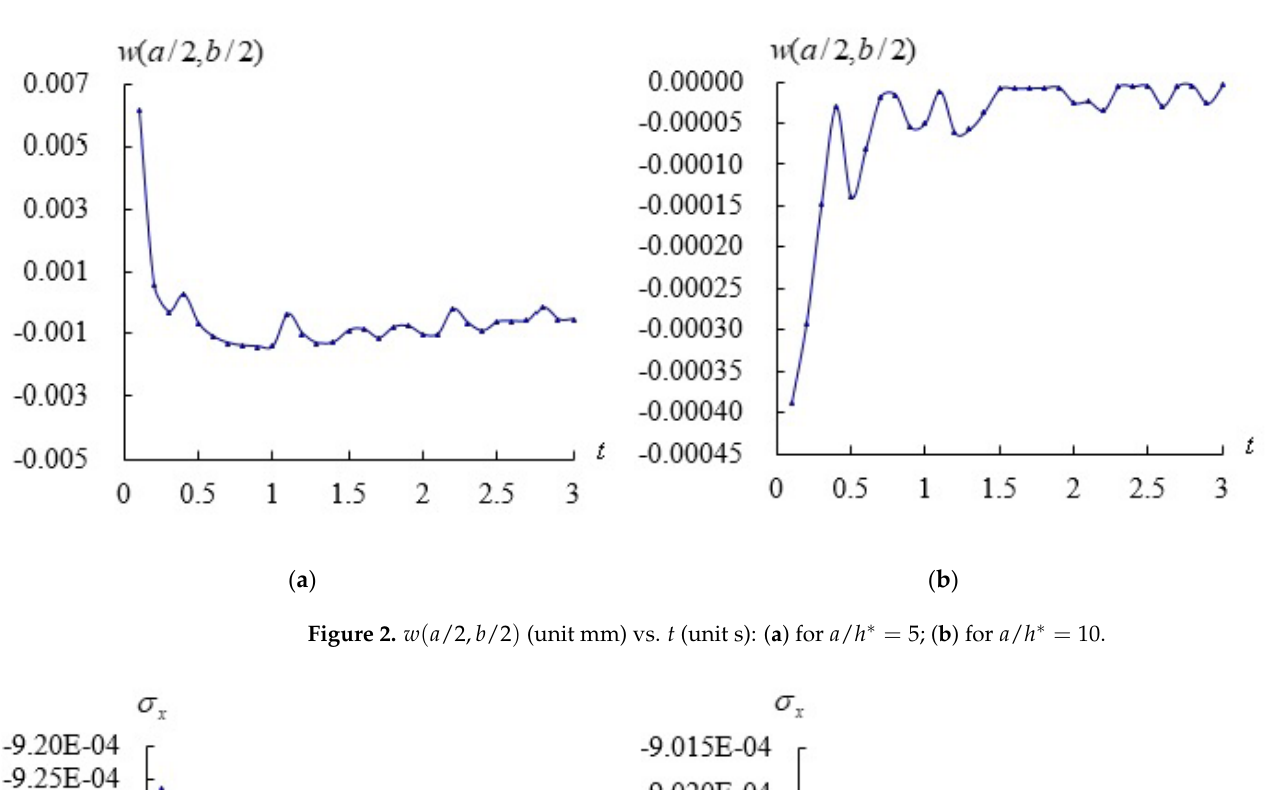
values of w ( a /2, b /2 ) for R n = 0.5, 1 and 2 can proceed in higher T = 1000 K of temperature condition. The center deflection amplitude values are almost keep constant versus T for R n = 10. Figure 4b shows the R n curves in a / h ∗ = 10; the value of maximum w ( a /2, b /2 ) is 0.000119 mm found at T = 1000 K for R n = 2. The absolute values of w ( a /2, b /2 ) for R n = 2 can proceed in higher T = 1000 K of temperature condition.